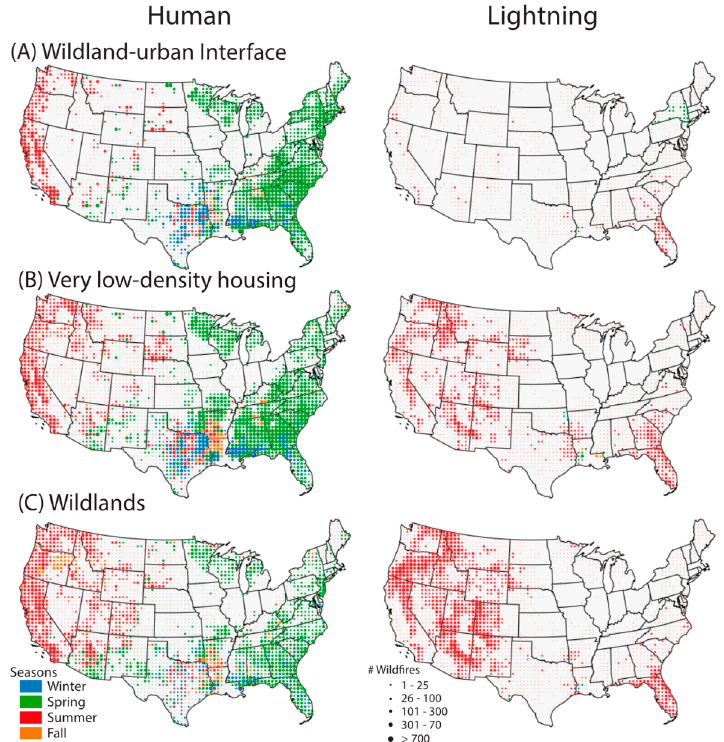
Figure 4. Spatial representation of season that fire ignition was most prevalent across all classes stratified by human and lightning started wildfire in ( A ) WUI, ( B ) very-low-density housing, and ( C ) wildlands. Winter is defined as the months of December, January, February; Spring as March, April, May; Summer as June, July, August; Fall as September, October, December. Dot sizes indicate the total number of wildfire ignitions from 1992–2015 in a 50-km grid cell.